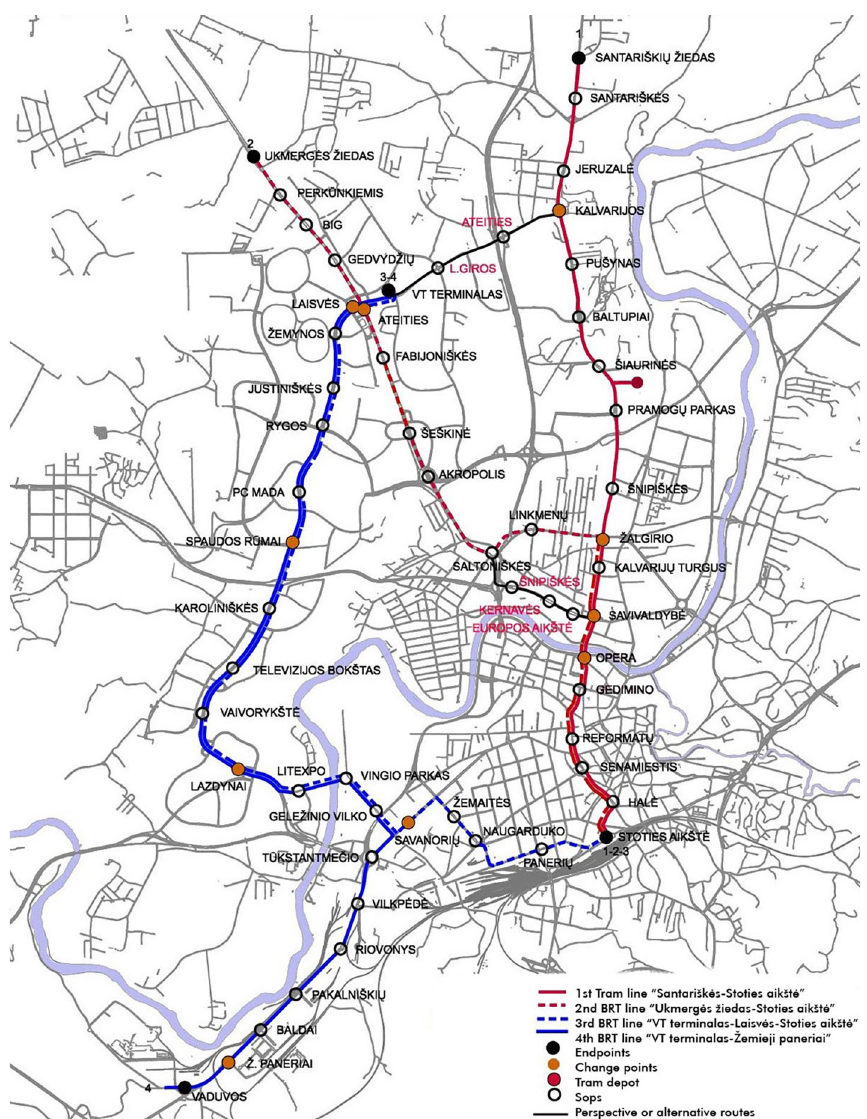
Fig. 1. The network of new public transport modes in Vilnius City in the year